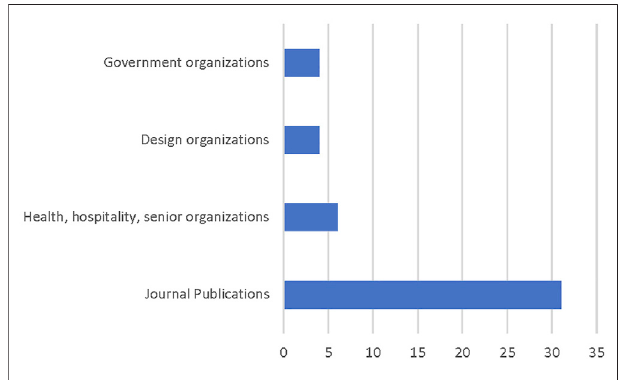
FIGURE 2 | Distribution of references (N (cid:1)